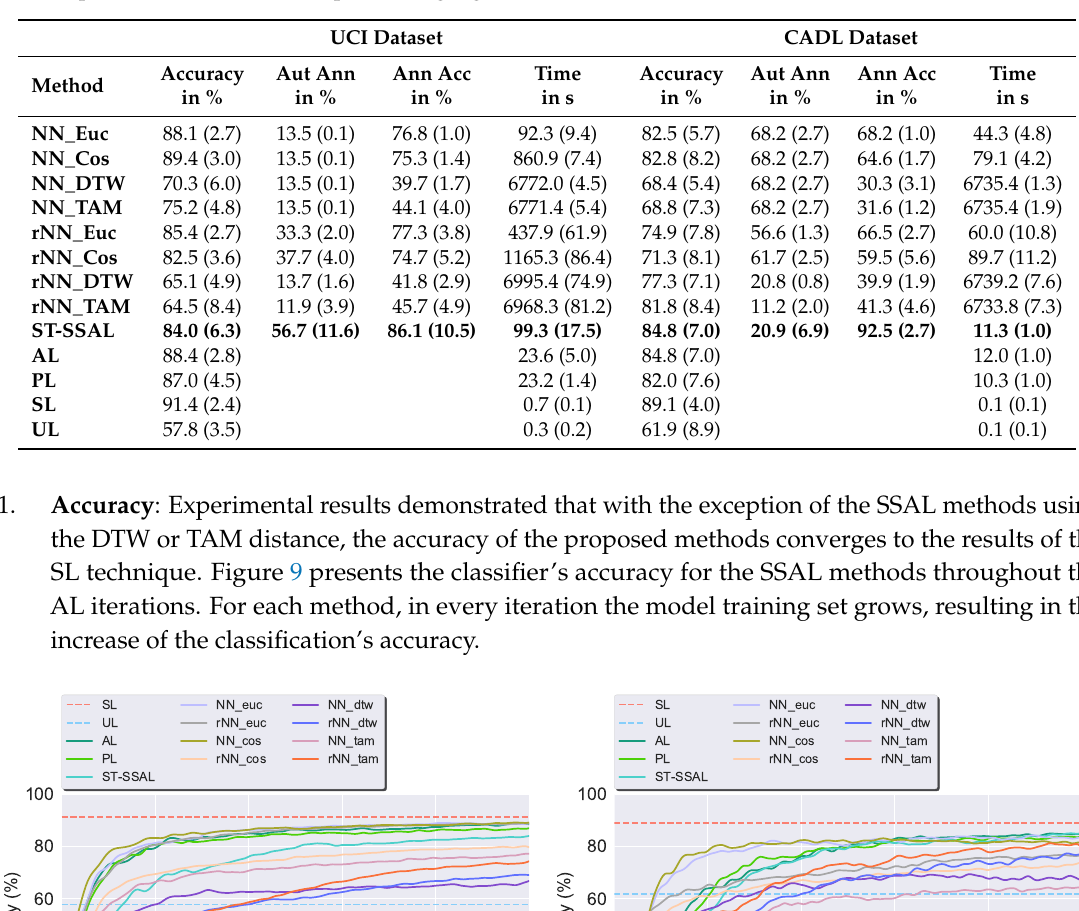
Table 4. Experimental results for the SSAL methods: accuracy, automated annotation percentage, automated annotation accuracy and the algorithm’s execution time. For all listed values it is shown its 10-fold CV average and standard deviation, the latter between parenthesis. Following the underscore in the NN and rNN methods: Euc, Cos, DTW and TAM, denote the similarity distances used in the respective method. The best performing algorithm is shown in bold for each dataset.